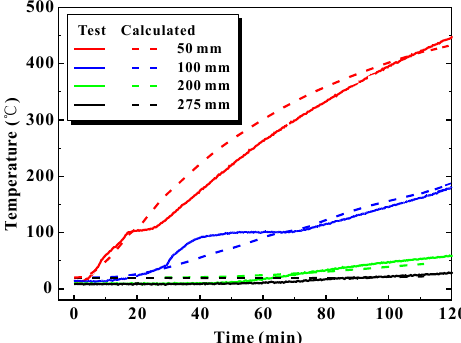
Figure 11. Comparison of calculated and recorded temperature-time curves related to Section 2-2 of Specimen S120C.